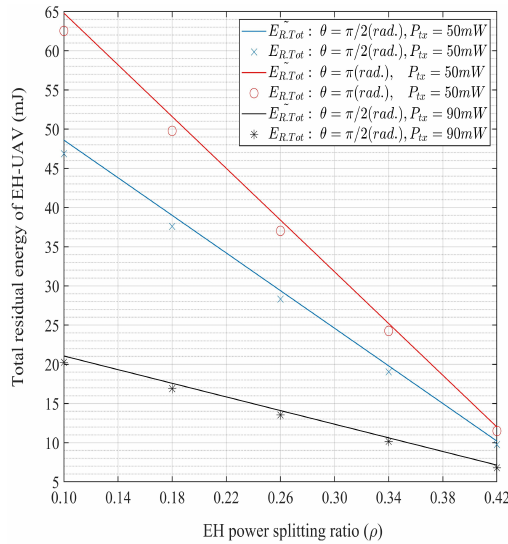
Figure 3. Total residual energy and its approximation with respect to energy harvesting (EH) power splitting ratio for θ = { π /2, π } and P tx = { 50,90 }